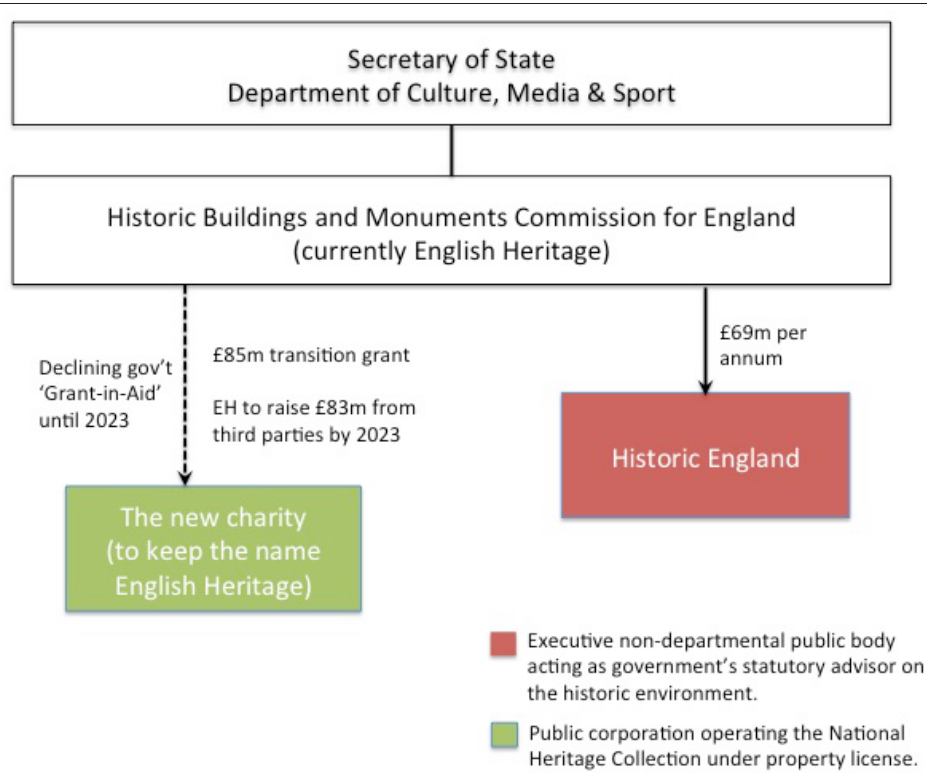
Figure 2: Illustration of how the current organisation will be split over the period